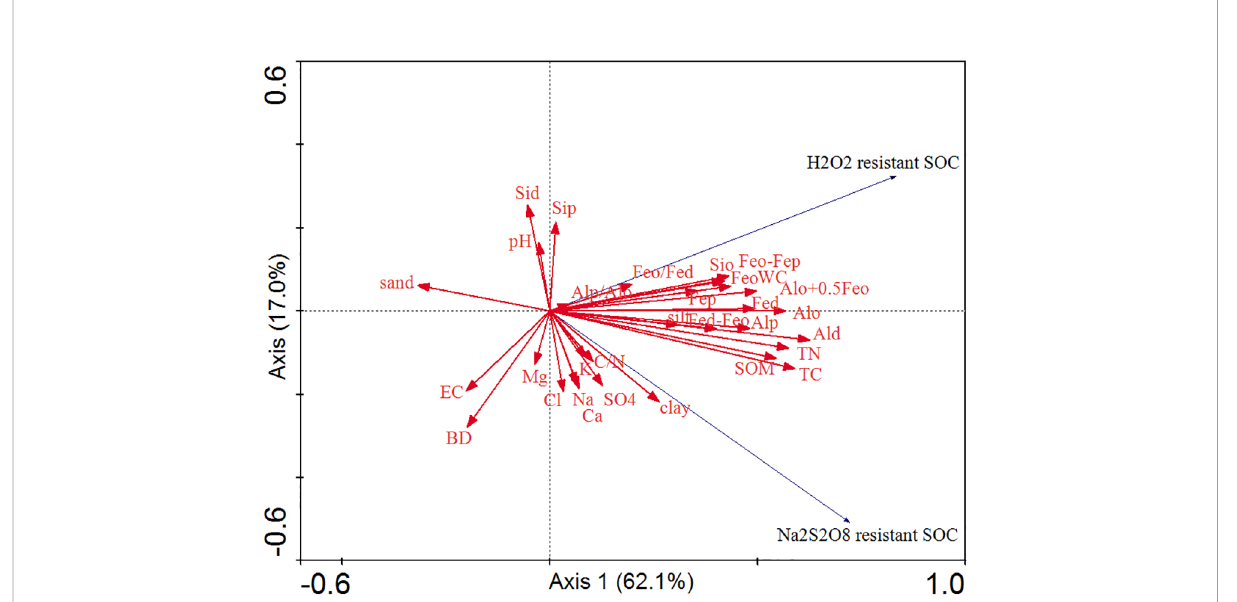
FIGURE 5 Redundancy analysis between the two stabilized SOC fractions, Fe/Al/Si oxides, mineral phase indicators, and soil